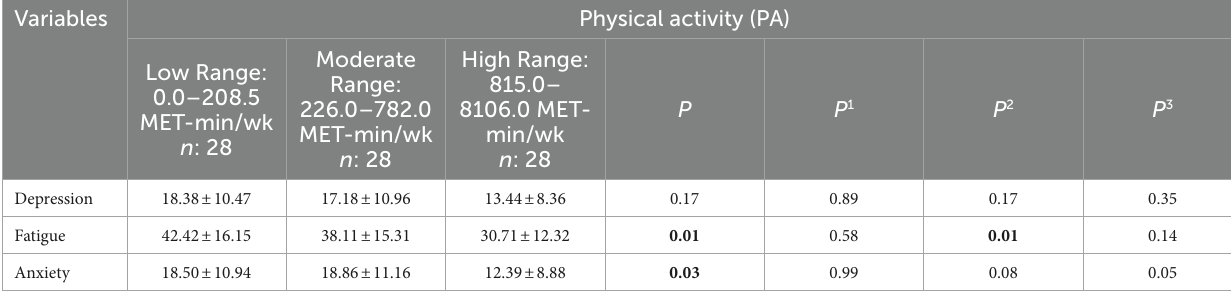
TABLE 5 The difference in fatigue, anxiety, and depression scores between physical activity